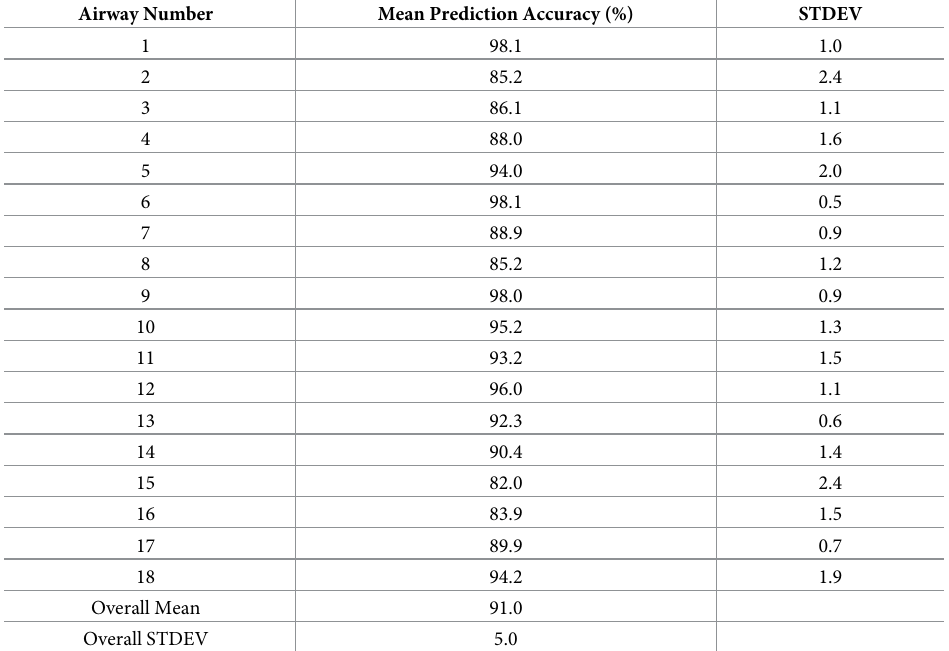
Table 2. The precision accuracy of identifying the correct lung airway by MVCNN during FBG navigation. The results represent the mean and standard deviation of ten